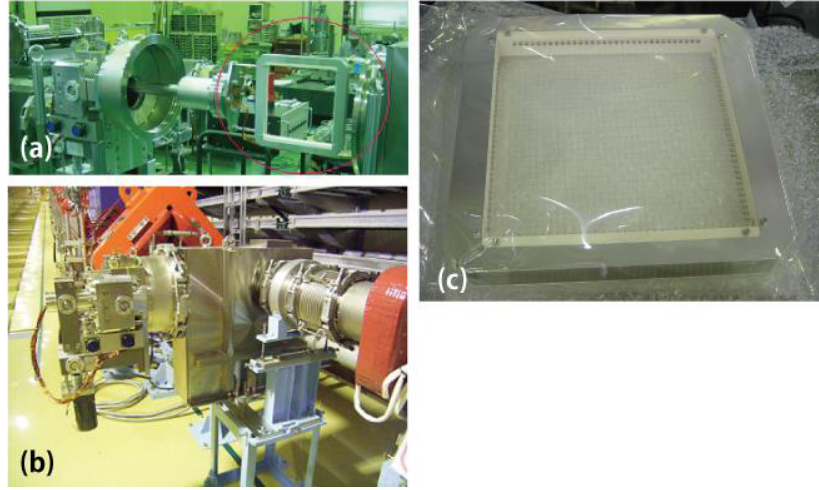
Figure 18. Photographs of Multi Wire Profile Monitor (MWPM) with SiC wires for beam diagnostic along proton beam transport. ( a ) Photograph of MWPC assembled in a chamber. ( b ) Photograph of the chamber containing MWPC installed in the proton beam transport line. ( c ) Photograph of a MWPM frame on which 31 wires of SiC are installed in both horizontal and vertical direction.